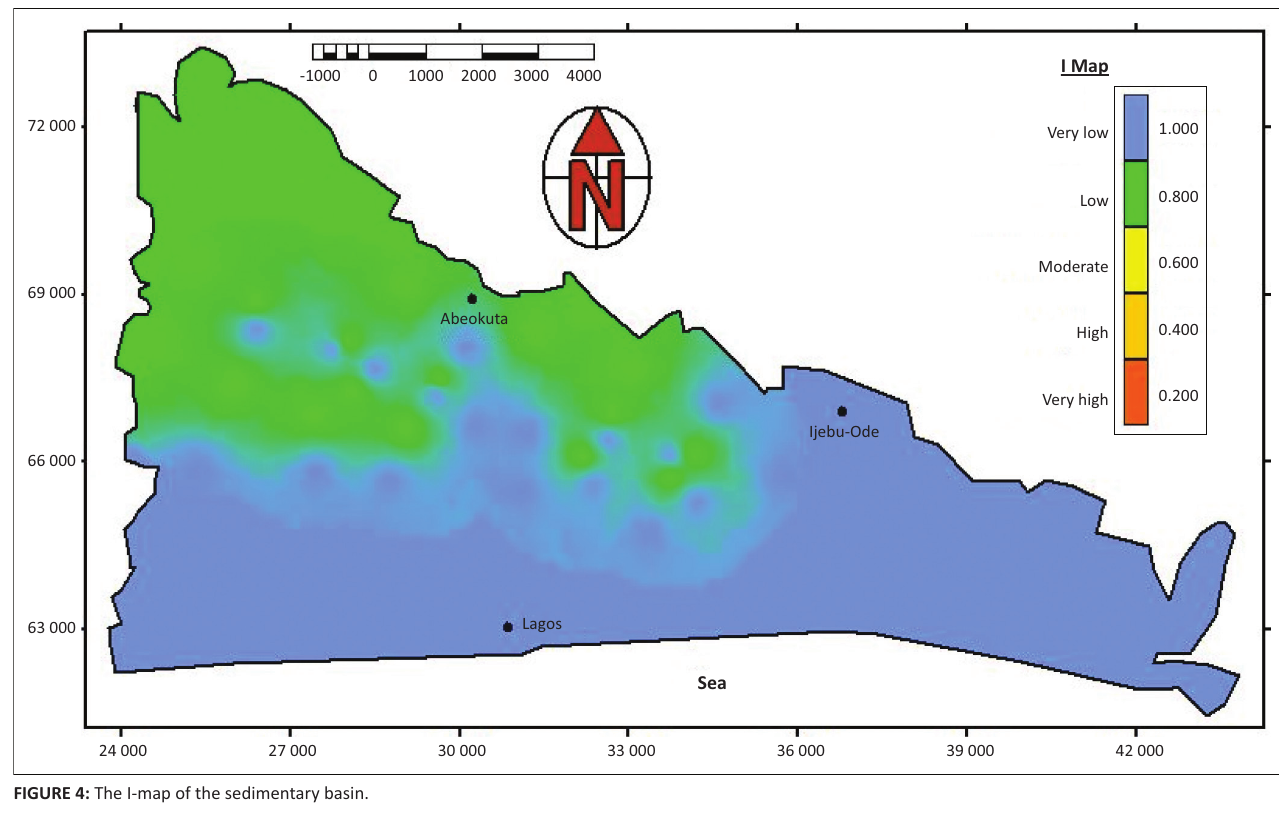
FIGURE 4: The I-map of the sedimentary basin.